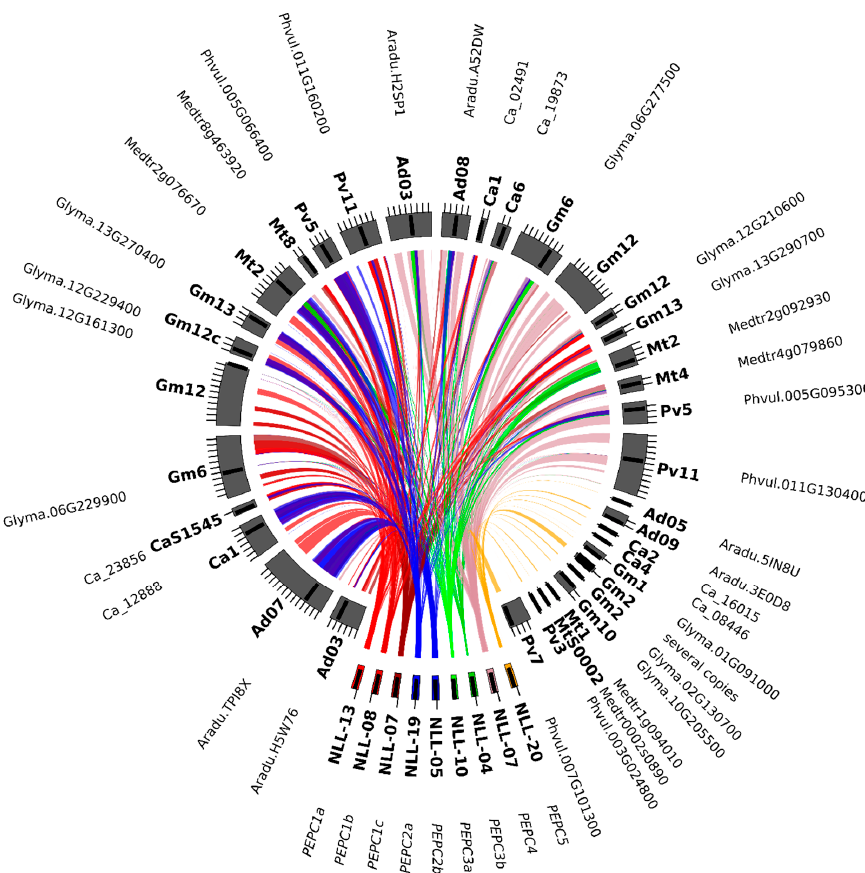
Figure 7. Comparative mapping and phylogenetic inference of legume PEPC genes. Syntenic patterns revealed for narrow-leafed lupin genome regions and corresponding regions of legume chromosomes. NLL — narrow-leafed lupin linkage group, Pv —P. vulgaris , Mt —M. truncatula , Gm —G. max , Ca —C. arietinum , and Ad —A. duranensis .